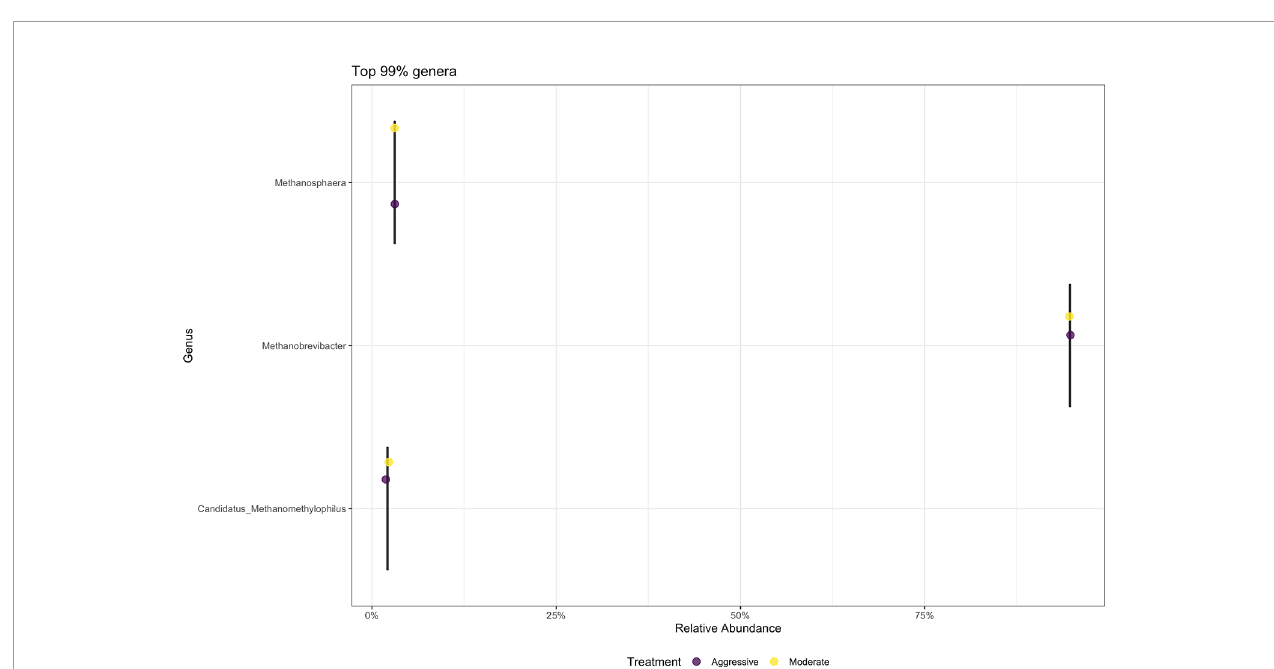
FIGURE 7 | Average relative abundance of the top 99% genus-level archaeal communities classi fi ed in ruminal fl uid between aggressive and moderate implant strategies. Mean relative abundance of archaeal communities associated with the aggressive implant strategy are represented in purple and moderate implant strategy in